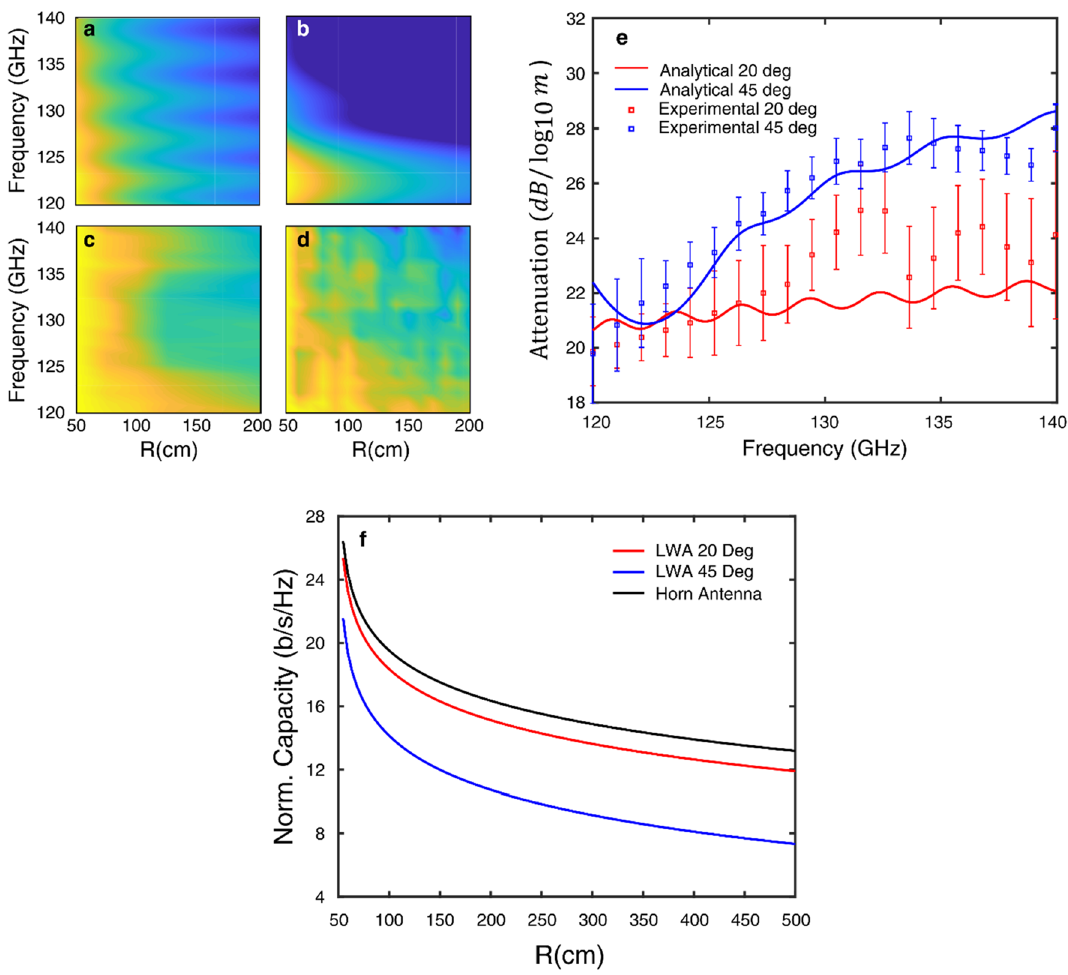
Figure 4. The receiver is positioned at θ = 20 ◦ , 42 ◦ and the distance, R is increased from 0.5 to 2 m . ( a ) The results of analytical model from Eq. (5) at θ 0 = 20 ° and (b) at θ 0 = 45 °. The experimentally measured power of each of the 20 tones plot as a function of distance at ( c ) 20 ° and ( d ) 45 °. The attenuation, A, is extracted from fitting the results to Eq. (7). ( e ) The attenuation calculated from the analytical and experimental results show an increase in attenuation at 45 ° compared to 20 °, and this increases in frequency. The error bars show the 95% confidence interval for each of the fit. The average sum of squared residuals was 0.755 and 0.879 for the 45 ° and 20 ° fits. ( f ) The calculated Shannon capacity for a 122.5 GHz signal with a bandwidth of 5 GHz, as a function of distance for a link using a LWA or a traditional horn antenna (black line). The horn antenna link experiences FSPL, whereas a LWA transmitting to a receiver positioned at 45° (blue line) undergoes increased path loss resulting in a lower capacity. Comparatively, if the receiver were to be positioned 20° (red line), the path loss is less and the capacity is horn antenna with identical antenna gain, transmit power and noise experiencing only FSPL is also presented. The LWA has a decreased capacity due to the spread of the bandwidth and filtering effect from the receiver compared to a horn antenna. Finally, we show the effect of angular dispersion on a communication link by transmitting a 2.5 Gbaud/s binary phase shift keyed (BPSK) and a quadrature phase shift keyed (QPSK) signal. We transmit each signal through the LWA at carrier frequencies of 120 GHz and 140 GHz. The receiver is positioned at angles of 20° and 45° and distances of 50 cm and 200 cm. The attenuation in SNR (dB) resulting from moving the receiver from 50 to 200 cm is tabulated in Fig. 5a,b. Clearly, the decrease in SNR is greater at 45° than at 20° for both modulation schemes. This result is consistent with the increased attenuation at higher angles, as noted above. The increase in attenuation at 45° leads to a faster deterioration of the signal, resulting in a lower SNR. The constellation diagrams of the received BPSK and QPSK (Fig. 5c–f) illustrates the increase in noise at 45° compared to 20°. As the bandwidth of the data, and the receiver distance increases the impact on signal quality is also expected to be more severe. In modulation schemes sensitive to the bandwidth, this effect will be more pertinent.